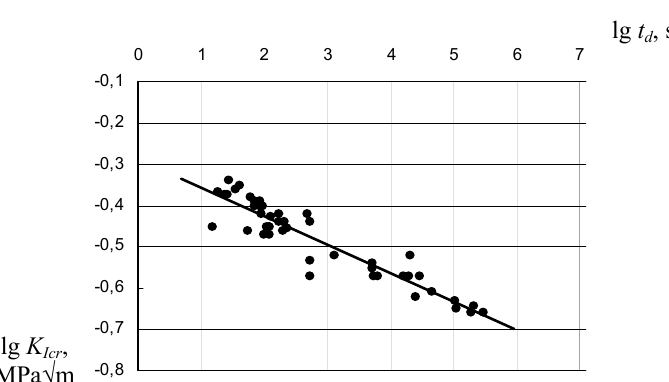
Figure 7: Fracture toughness of glass under the long duration loading in